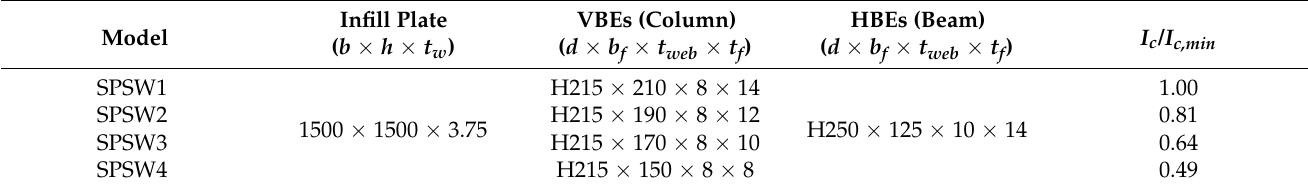
Table 1. Specifications of the four SPSW models with different column flexural stiffnesses (mm).